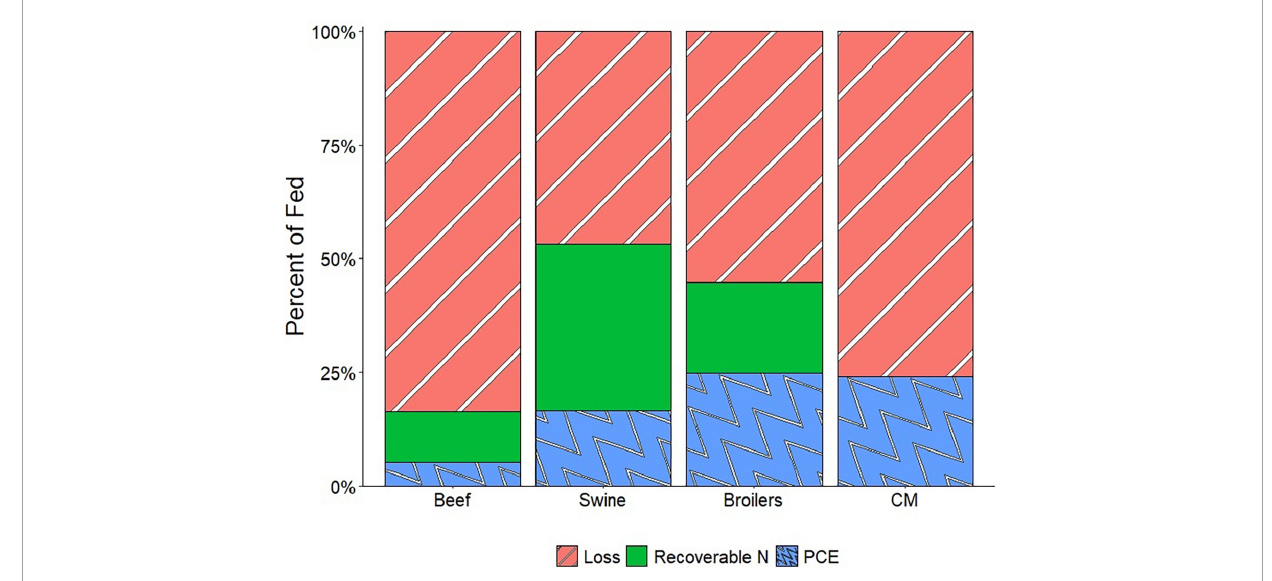
FIGURE5 Nitrogen use efficiencies compared for beef, swine, broilers, and cultured meat with no nitrogen recovery. Values are based on protein conversion efficiencies (PCE) and nitrogen availability in livestock manures.